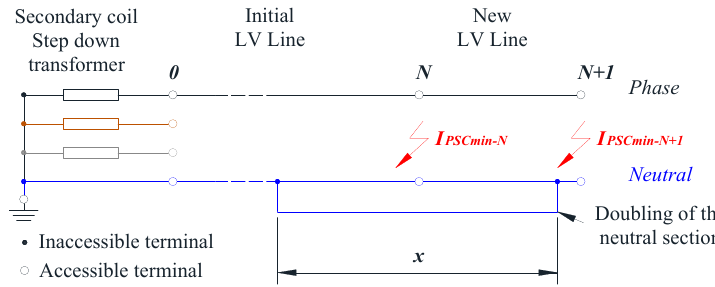
Figure 4. Radial distribution grid of modified LV.